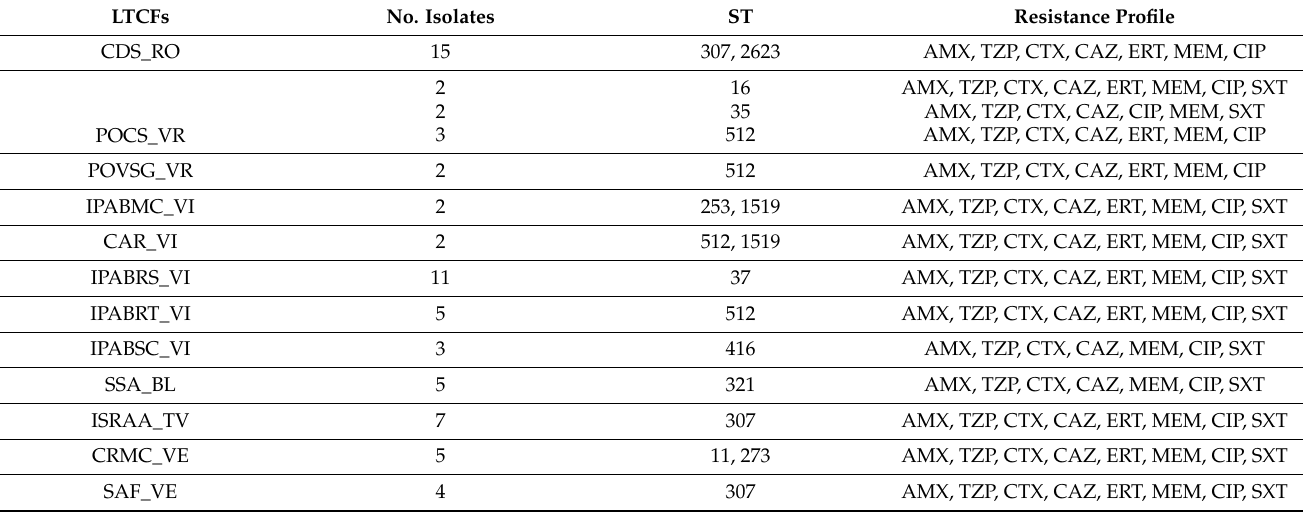
Table 1. Antimicrobial susceptibility of 68 K. pneumoniae isolated from rectal swabs.